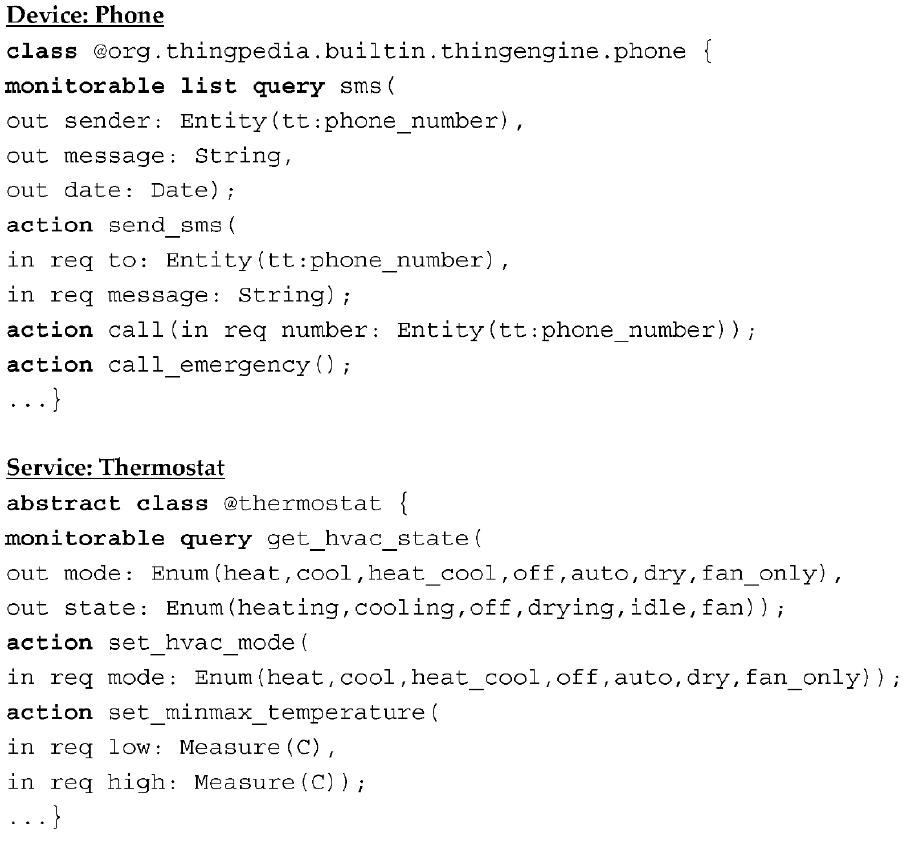
Figure 1. Snapshots of class examples in